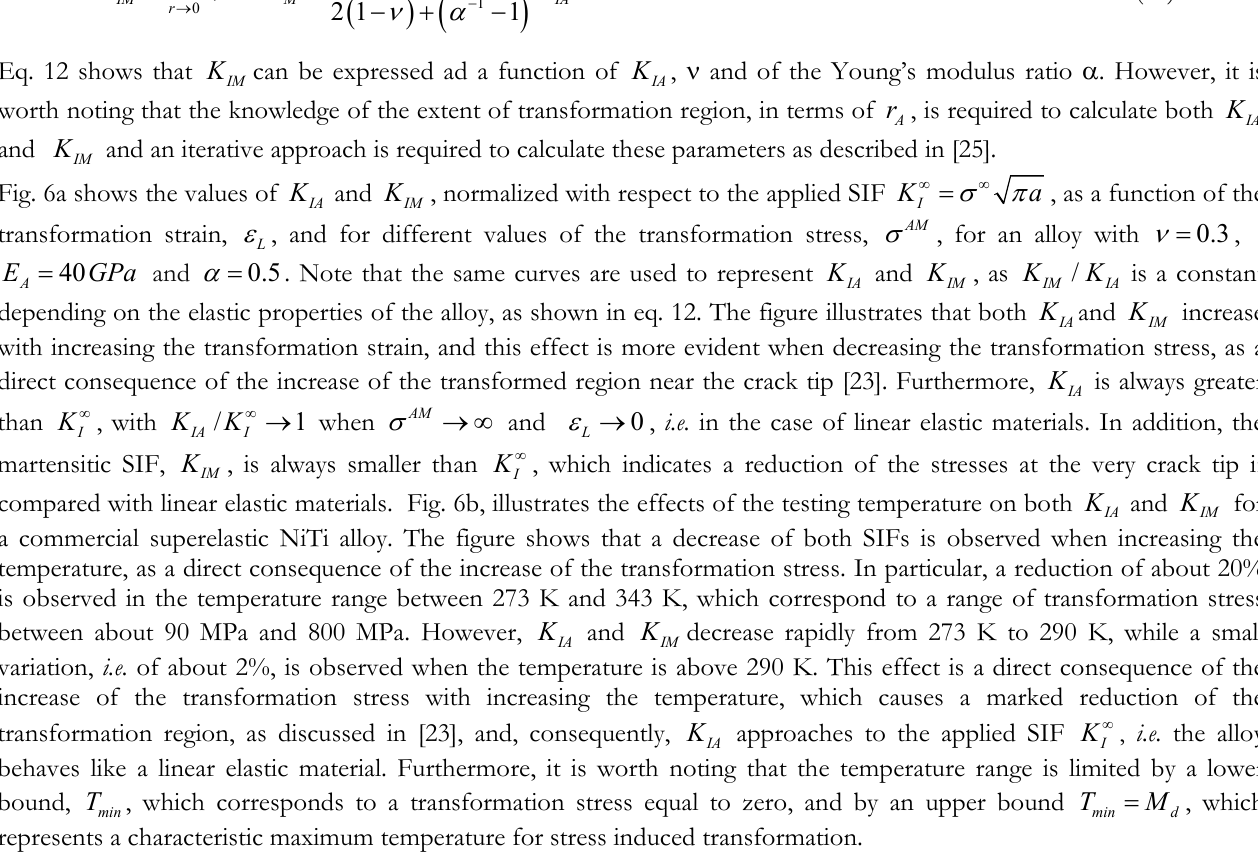
K  , as a function of: a) the I